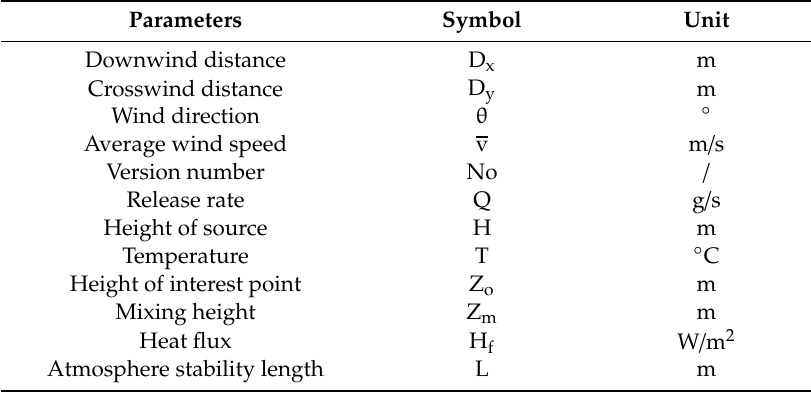
Table 1. A parameter description of the Project Prairie Grass